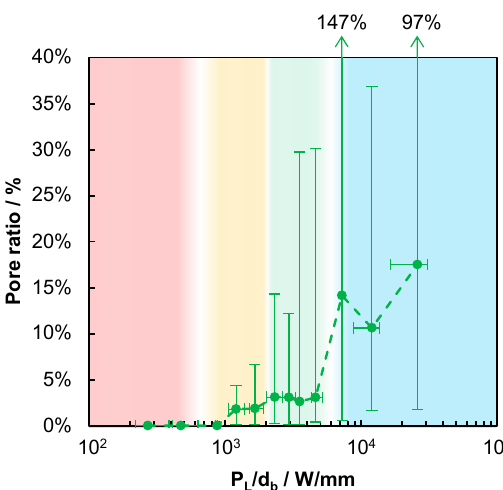
Figure 6. Pore ratio A P / A a as a function of P L / d b . The highlighted areas correspond to the high- lighted areas in Figure 5 (Red-colored area: complete failure of the additive process with η P = 0. Yellow-colored area: occasional failure of the additive process with minimum values of the error bars at 0% of η P . Green-colored area: reproducible additive process with efficiencies always >0% in all experiments. Blue-colored area: reproducible additive process with average efficiencies <5%, but always >0%).